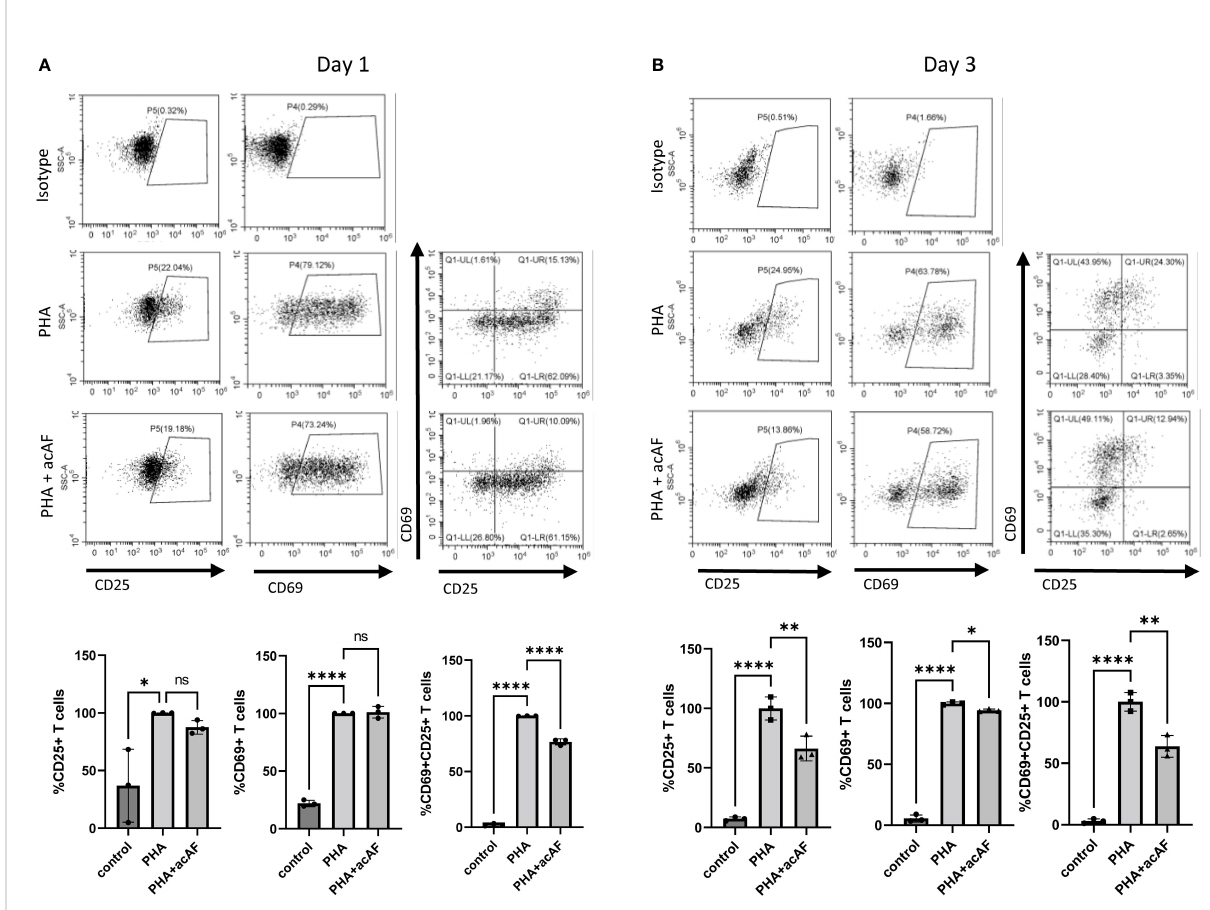
FIGURE 2 AcAF Attenuates T Cell Activation 1 and 3 days after PHA Stimulation CD69+ and CD25+ cells were gated from CD3+ T cell population. Cells expressing CD69, CD25, and both CD69 and CD25 were analyzed within T cell population following (A) 1-day PHA stimulation and (B) 3-day PHA stimulation in each group and graphed as percentages of the PHA vehicle control group. (Data graphed as mean ± SD; One way ANOVA with Tukey ’ s test; n=3-4 replicates for each group; ns=not signi fi cant; *=p<.05; **=p<.01; ****=p<.0001; Data is derived from 3 separate experiments. Each experiment used 1 independent PBMC donor treated with 1 of 3 acAF